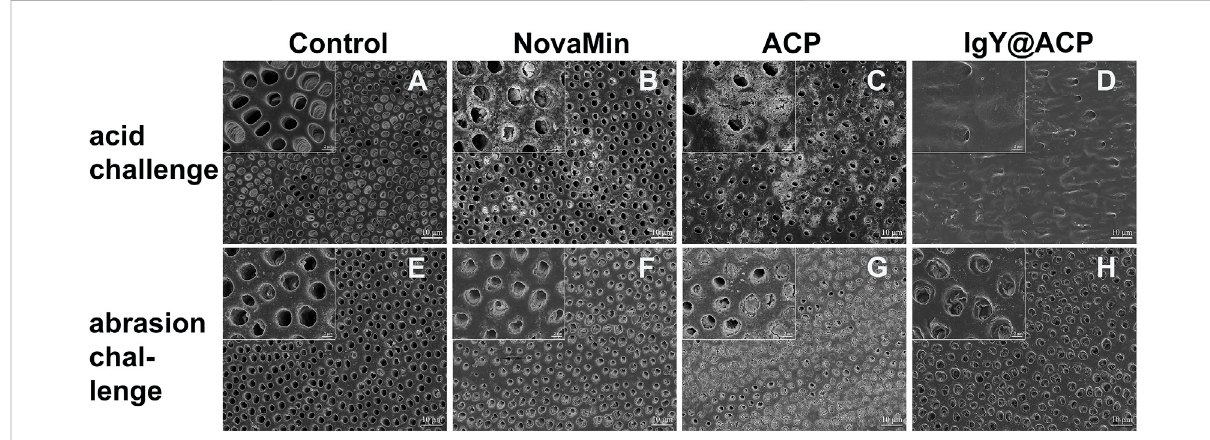
FIGURE 6 SEM micrographsofdentindisks treatedwith NovaMin,ACP, orIgY@ACPafter 6%critic acid (B – D) and abrasion (F – H) challenges. Dentin disks without treatment (A,E) were used as the control group.